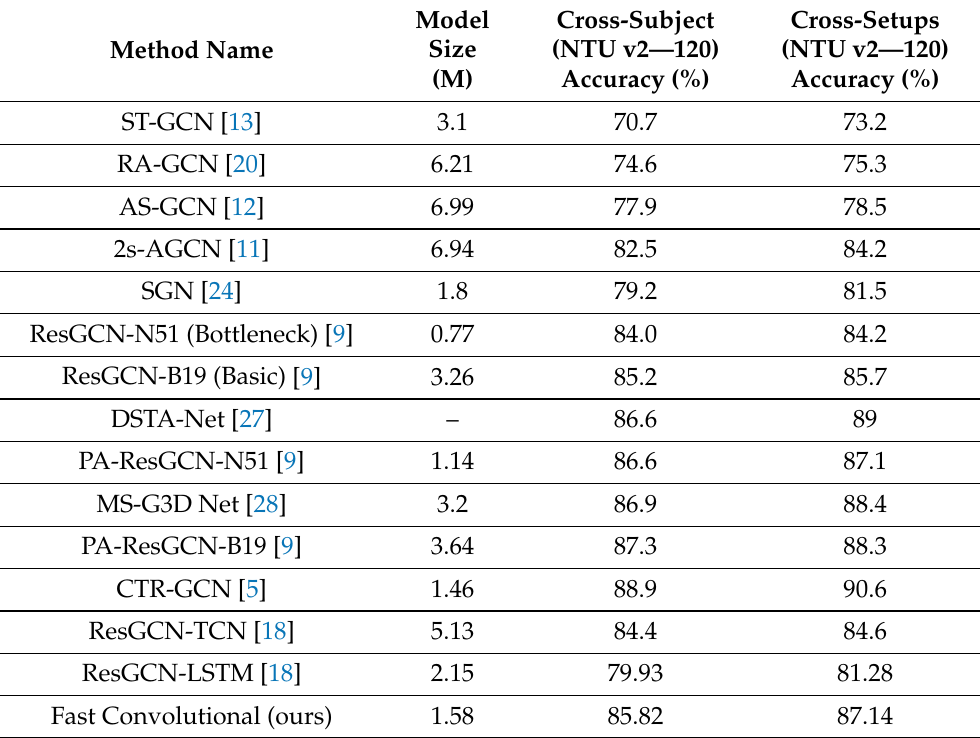
Table 7. Comparative results from the perspective of accuracy for the proposed test protocols in the second version of the NTU RGB+D dataset